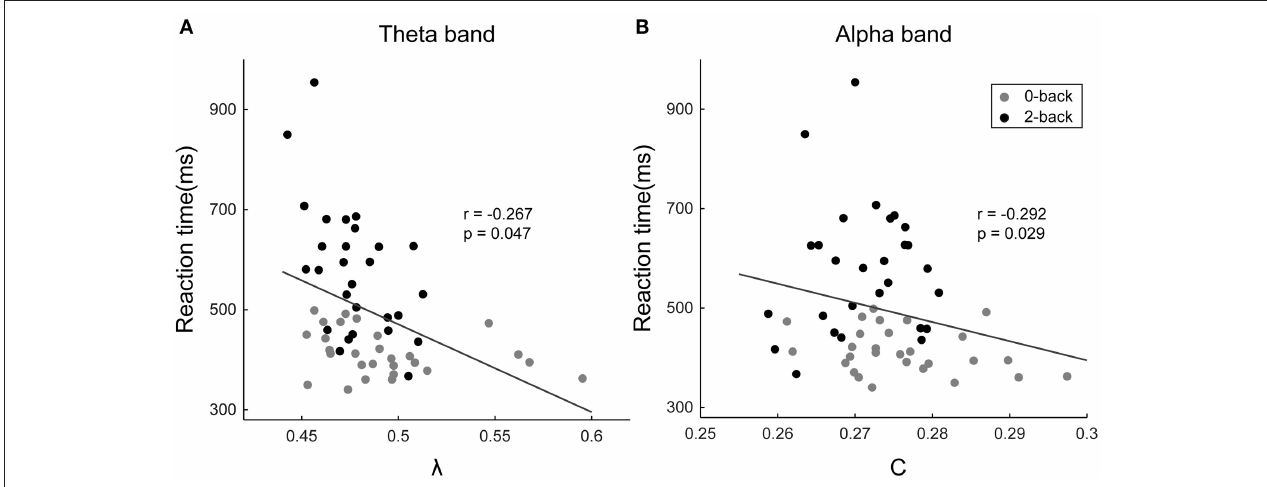
FIGURE 6 | Scatter plots showing the correlations between the subjects’ reaction time and (a) the normalized characteristic path length of the theta-band network and (B) the clustering coefficient of the alpha-band network. The horizontal axis represents the values of the respective graph metrics, and the vertical axis stands for the reaction time. The r - and p -values of the corresponding correlations are displayed in the